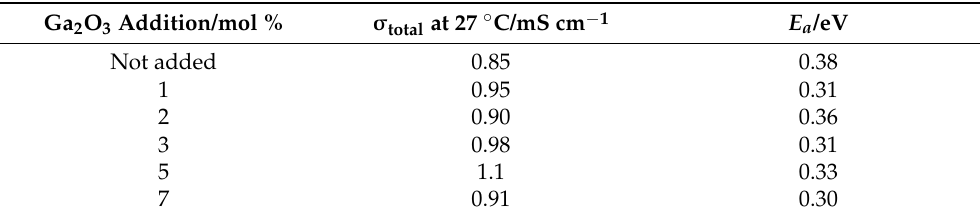
Table 2. Total ionic conductivity σ total at room temperature and activation energy E a for Ta-doped LLZO sintered with or without Ga 2 O 3 addition.